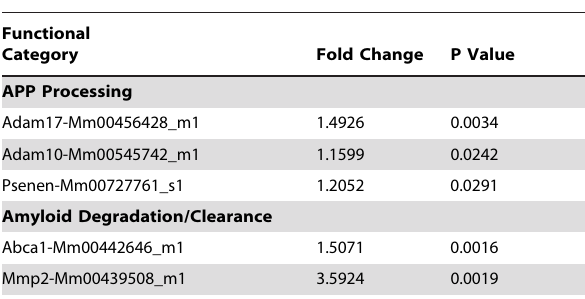
Table 1. 2-DG induced change in gene expression involved in amyloid production/clearance, mitochondrial function and Alzheimer’s disease.